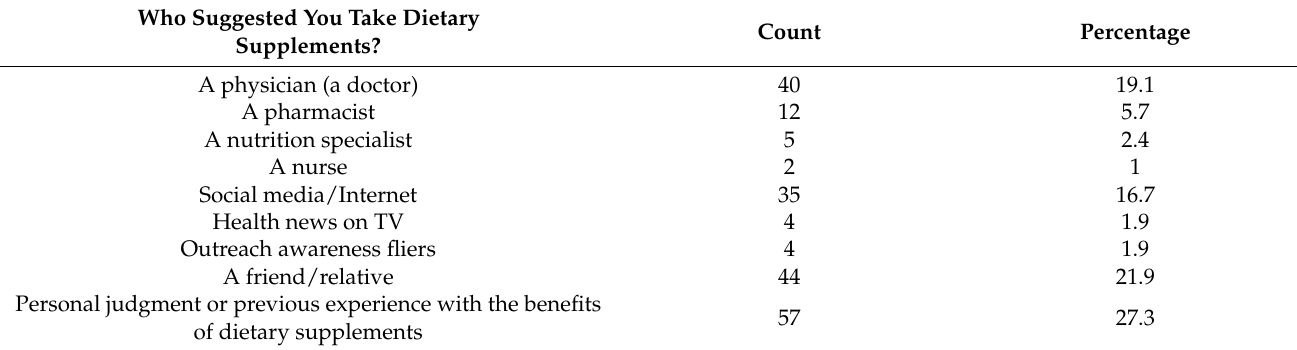
Table 8. Reference for dietary